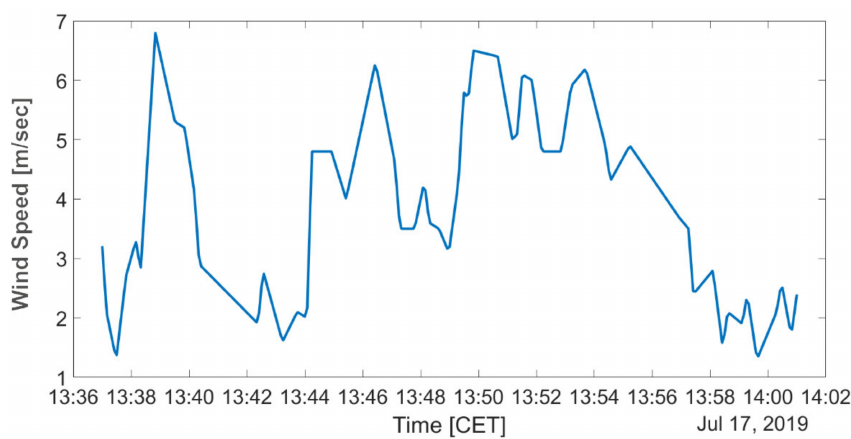
Figure 14. Wind speed in m / sec (downstream) measured by the wind turbine anemometers during the